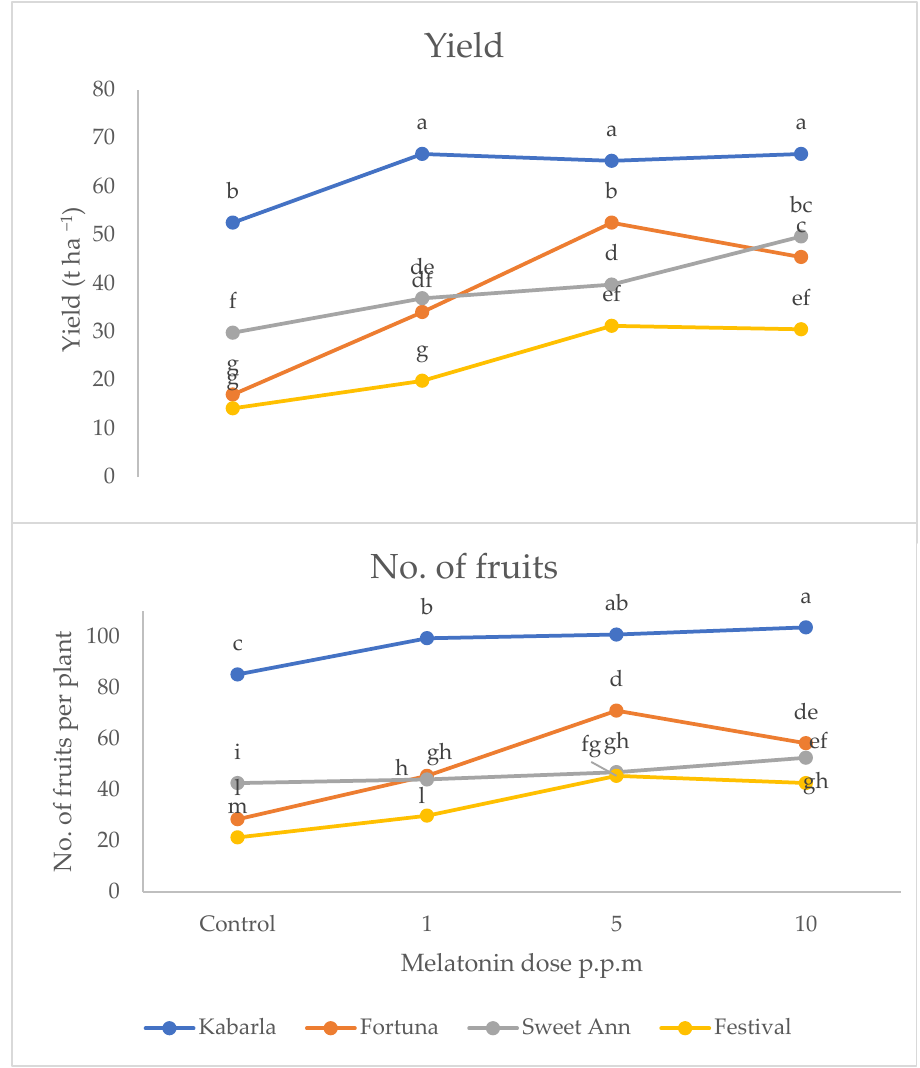
Figure 2. Interaction between cultivar and melatonin dose on yield and fruit number per plant of strawberry grown in Isparta (Turkey), the values followed by different letters are statistically different according to Tukey’s HSD test at p ≤ 0.05.